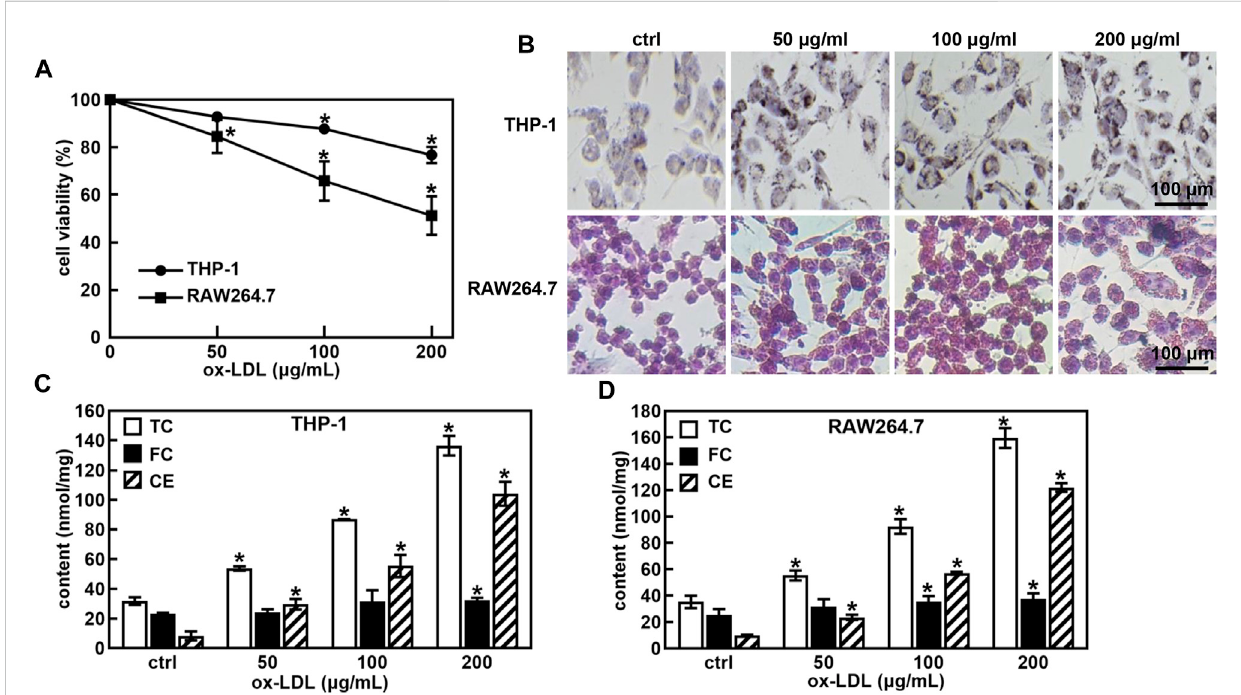
FIGURE 1 Ox-LDL induced thefoaming cell forming ofTHP-1 and RAW264.7macrophages.Effects ofox-LDLonthecell viability of THP-1 and RAW264.7 (A) ; ox-LDL induced cell morphological changes and lipid droplet formation analyzed by ORO staining ( B , 400X); Levels of total cholesterol (TC), free cholesterol (FC) and cholesterol ester (CE) in ox-LDL induced foaming cells (C,D) . * p < 0.05 vs. the control (ctrl)